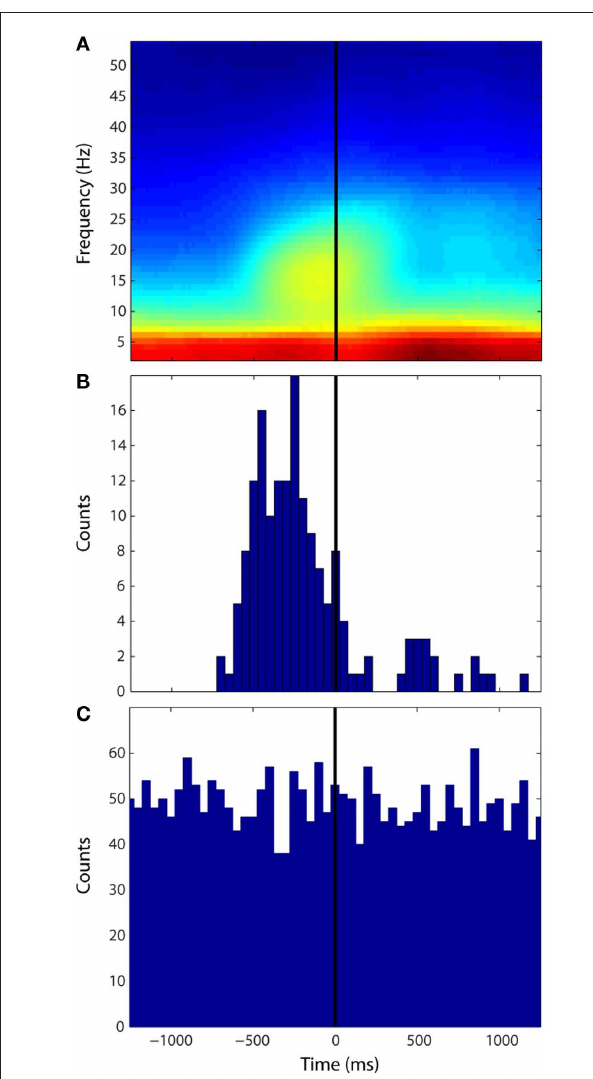
Figure 2 | Distributions of onset of power increase in beta frequency and onsets of sustained wave during the engaged condition. All three figures are aligned to the instruction cue. (A) Averaged spectrogram across all the channels and all trials. The pseudo color scaling ranges from − 10 to 35 dB. (B) Distribution of onset of increase in beta power. (C) Distribution of sustained wave onsets. The bin size for the histograms (B,C) is 20 ms.